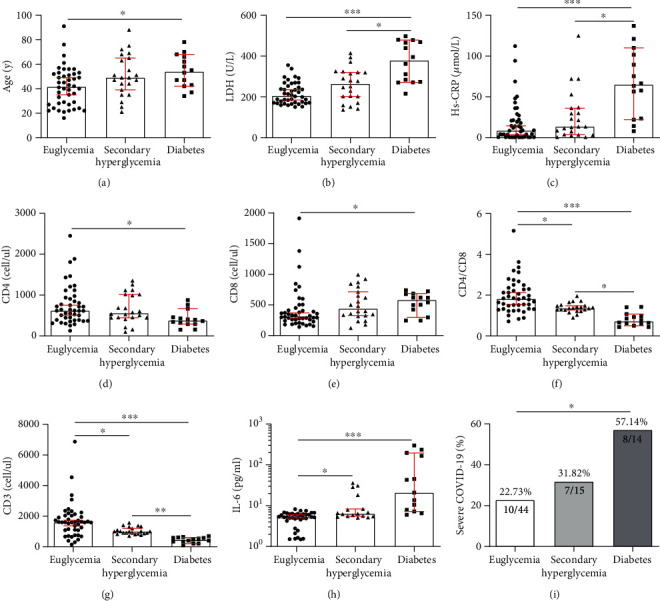
Comparison of laboratory findings in each group, ∗P < 0.05; ∗∗P < 0.01; ∗∗∗P < 0.001. Hs-CRP: high-sensitive C-reactive protein; IL-6: interleukin-6.